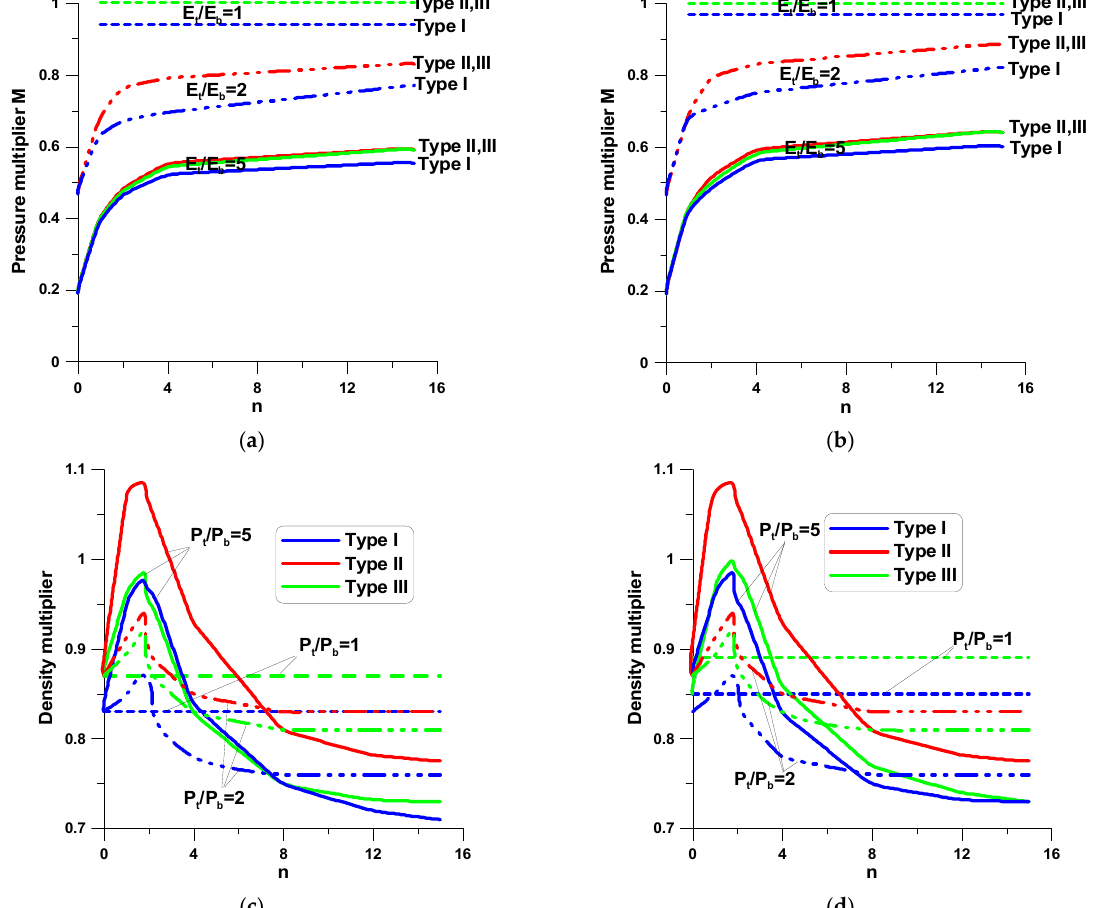
Figure 3. Distributions of correction multipliers and three types of porosity distributions. ( a ) Pressure multiplier M − c p = 0.2. ( b ) Pressure multiplier M − c p = 0.5. ( c ) natural frequencies multiplier M ˆ − c p = 0.2. ( d ) Natural frequencies multiplier M ˆ − c p = 0.5.